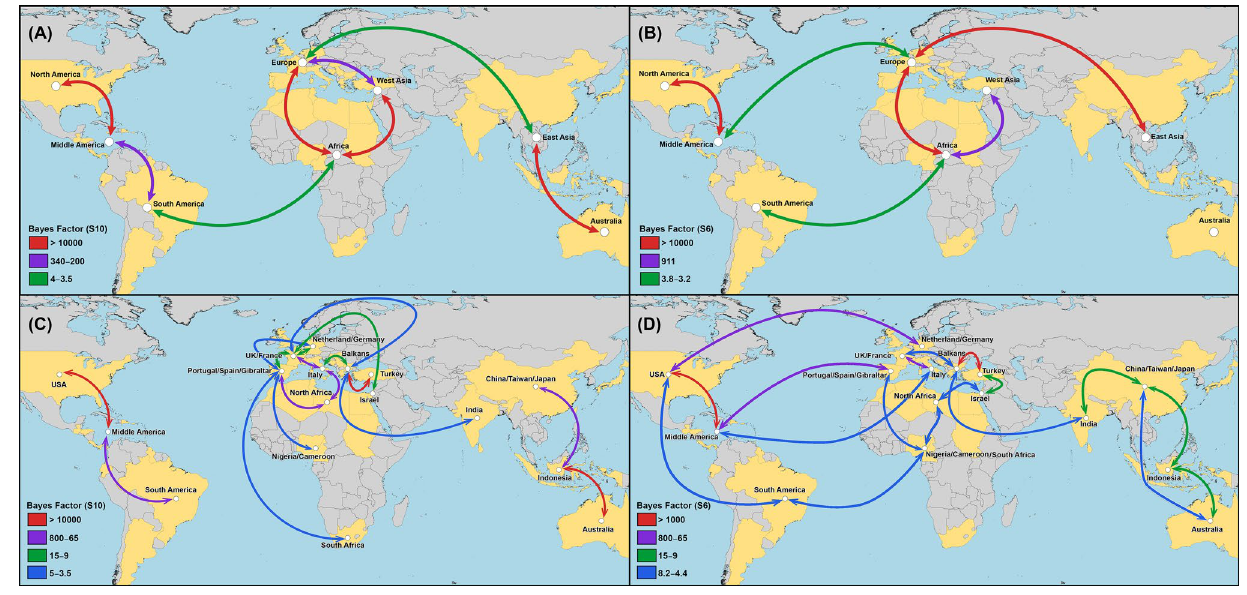
Figure 3. Global exchange routes of bluetongue virus. Bayesian stochastic search variable selection (BSSVS) was used to infer dispersal routes with none-zero rates using Bayes factors. Dispersal routes that were inferred to have significant support (Bayes Factor > 10) are plotted. Red arrows represent migration routes with the strongest statistical support (BF > 2000) as indicated by the legend on the lower left. ( A , B ) Dispersal routes inferred from continental level phylogeographic analysis ( C , D ) Dispersal routes inferred from country level phylogeographic analysis. ( A , C ) indicate segment 10. ( B , D ) indicate segment 6. Maps were generated using SPREAD3 version 0.96 (https ://rega.kuleu ven.be/cev/ecv/softw are/Sprea D3).